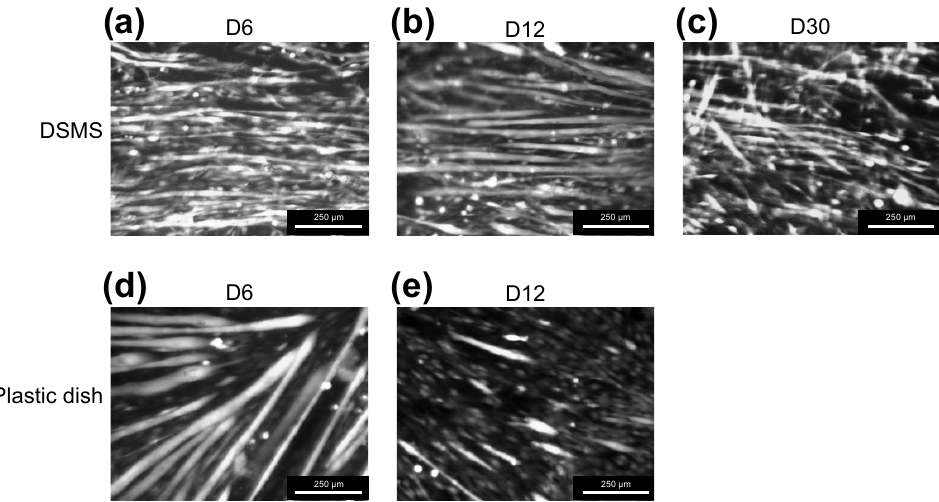
Figure 5. Comparison of cell survival. Live cells were stained with calcein. ( a – c ) Live cells on the DSMS; ( d , e ) Live cells on the plastic plate; ( a , d ) Differentiation day 6; ( b , e ) Differentiation day 12; ( c ) Differentiation day 30. In the culture on DSMS, detachment of myotubes was not observed even at 12 days of differentiation. Myotubes were still alive at 30 days of differentiation. In the culture on the plastic dish, myotubes were formed on Day 6 of differentiation, but many myotubes detached on Day 12. DSMS, decellularized skeletal muscle sheets.